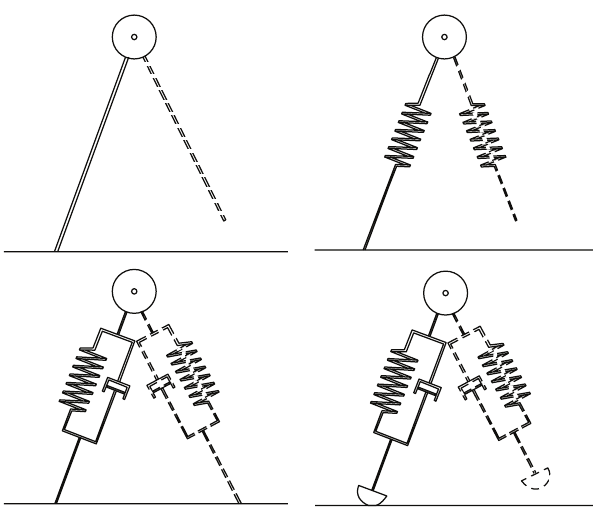
Figure 9: IPM models suggested in literature to model a walking human.